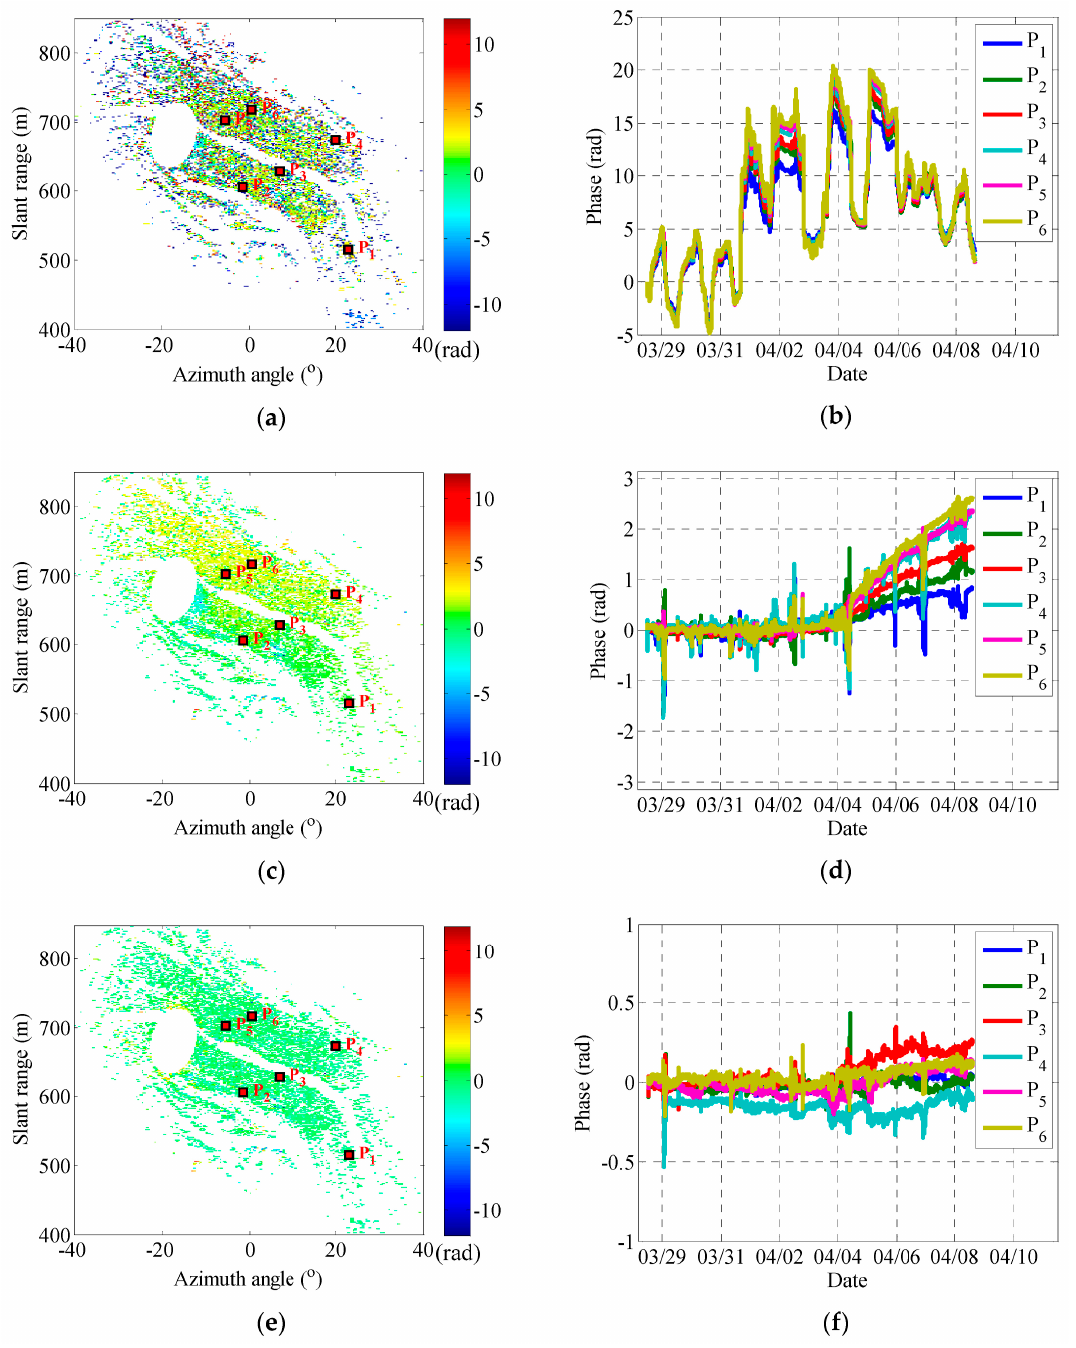
Figure 21. Cumulative phase maps: ( a ) Before the APC, after the APC ( c ) with the conventional method, and after the APC ( e ) with the improved method. Phase variation curves of six selected PSs P 1 to P 6 : ( b ) Before the APC, after the APC ( d ) with the conventional method, and after the APC ( f ) with the improved